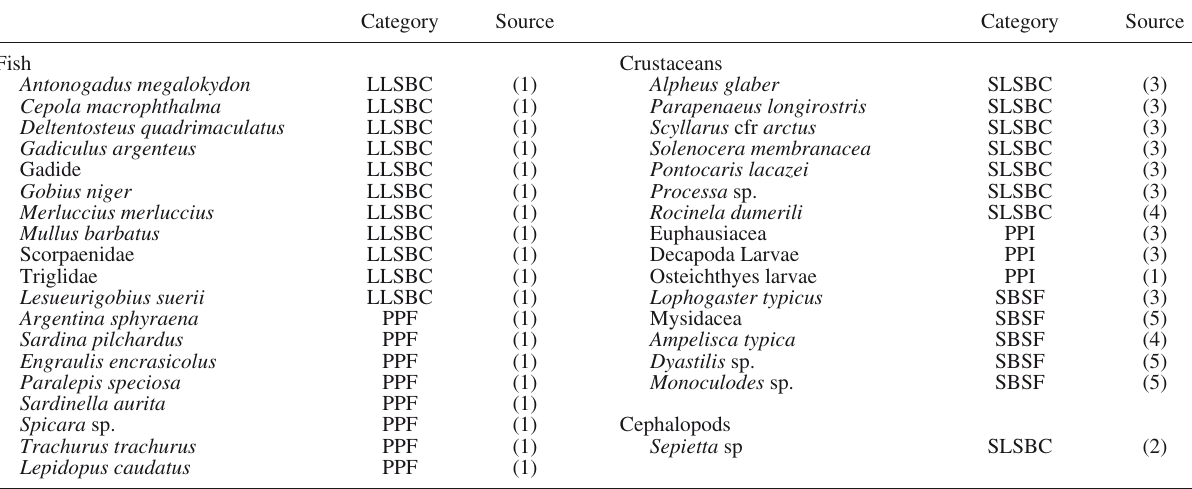
Table 1. – List of prey items with ecological category. LLSBC, long life span benthic carnivores; SLSBC, short life span benthic carnivores; PPF, pelagic planktivorous fish; PPI, planktonic planktivorous invertebrates; SBSF, supra benthic suspension-deposit feeders. Information on habitats, feeding habits and life cycles were obtained from (1) Fishbase (http://www.fishbase.org); (2) Sealifebase (http://www.sealifebase. org); (3) Cartes et al. (2002); (4) Fanelli et al. (2009a); and (5) Sainte-Marie and Brunel